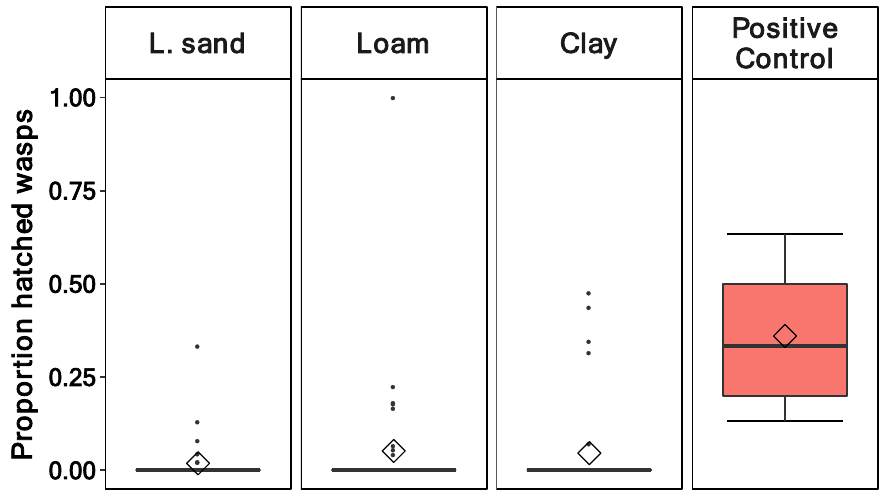
Figure 2. Proportion of hatched Trichopria drosophilae wasps out of pupae of Drosophila suzukii in the three soil types (loamy sand, loam, and clay) and the positive control where the wasp had free access to the pupae in a petri dish. (Soil types: n = 57, positive control: n = 5).